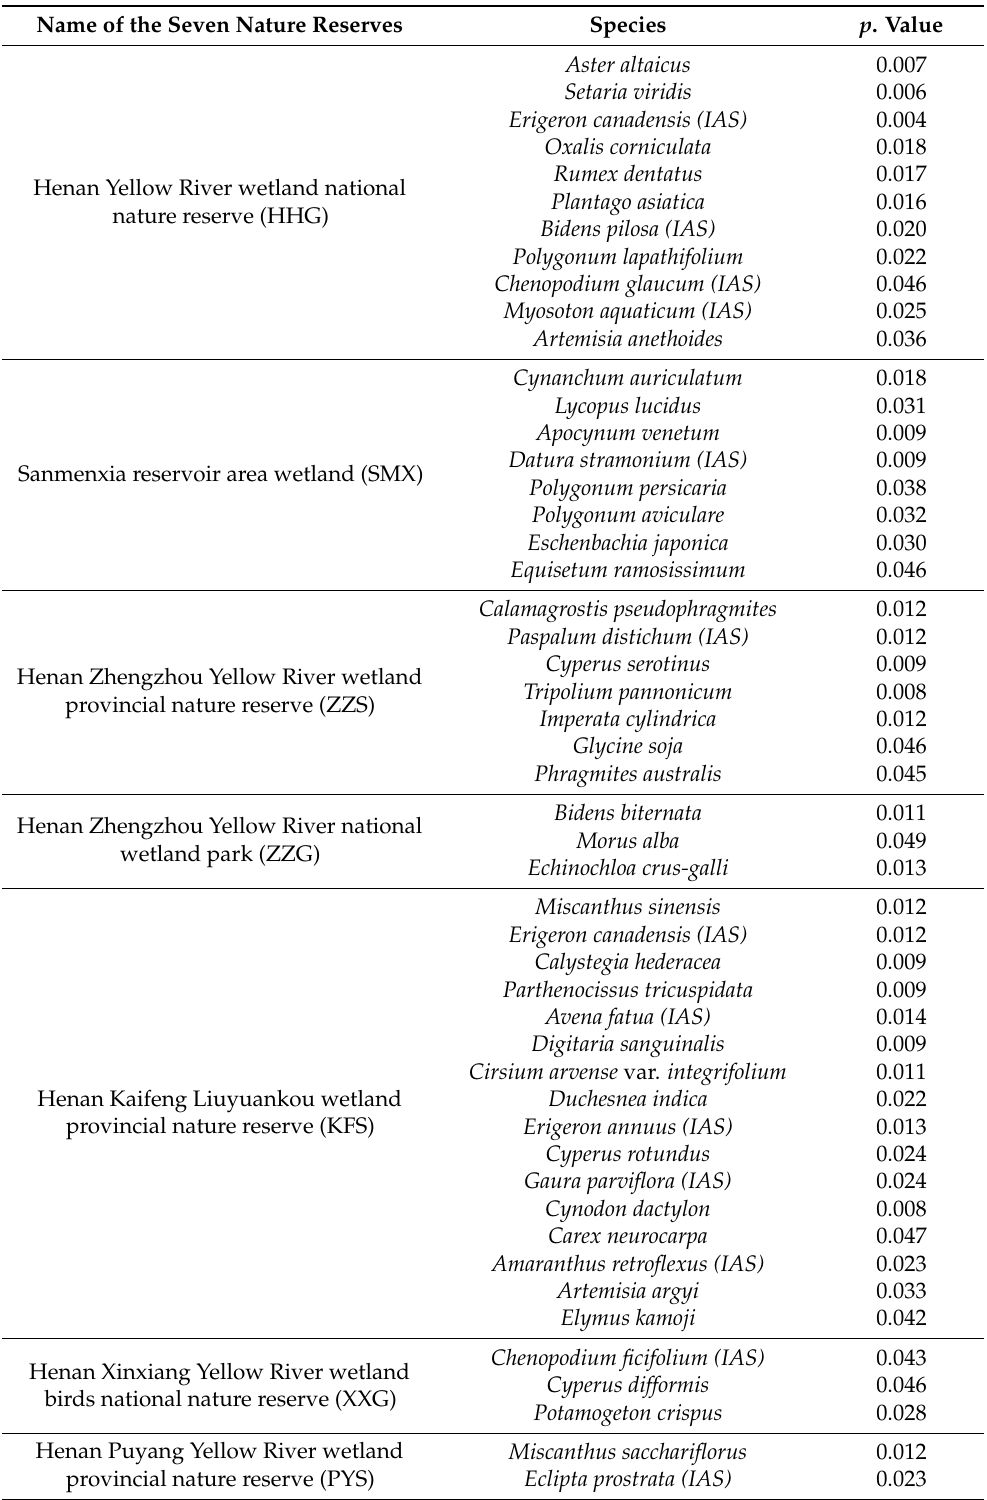
plants in the nature reserves. The beta diversity of the wetland plants in the nature reserves was negatively affected by precipitation and industrial output value. Table 1. Indicator species analysis in seven nature reserves of the Yellow River in Henan Province, China. Name of the Seven Nature Reserves